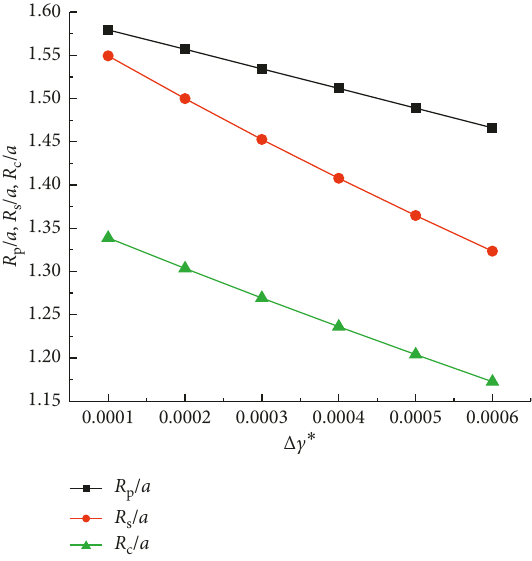
Figure 10: The values of R